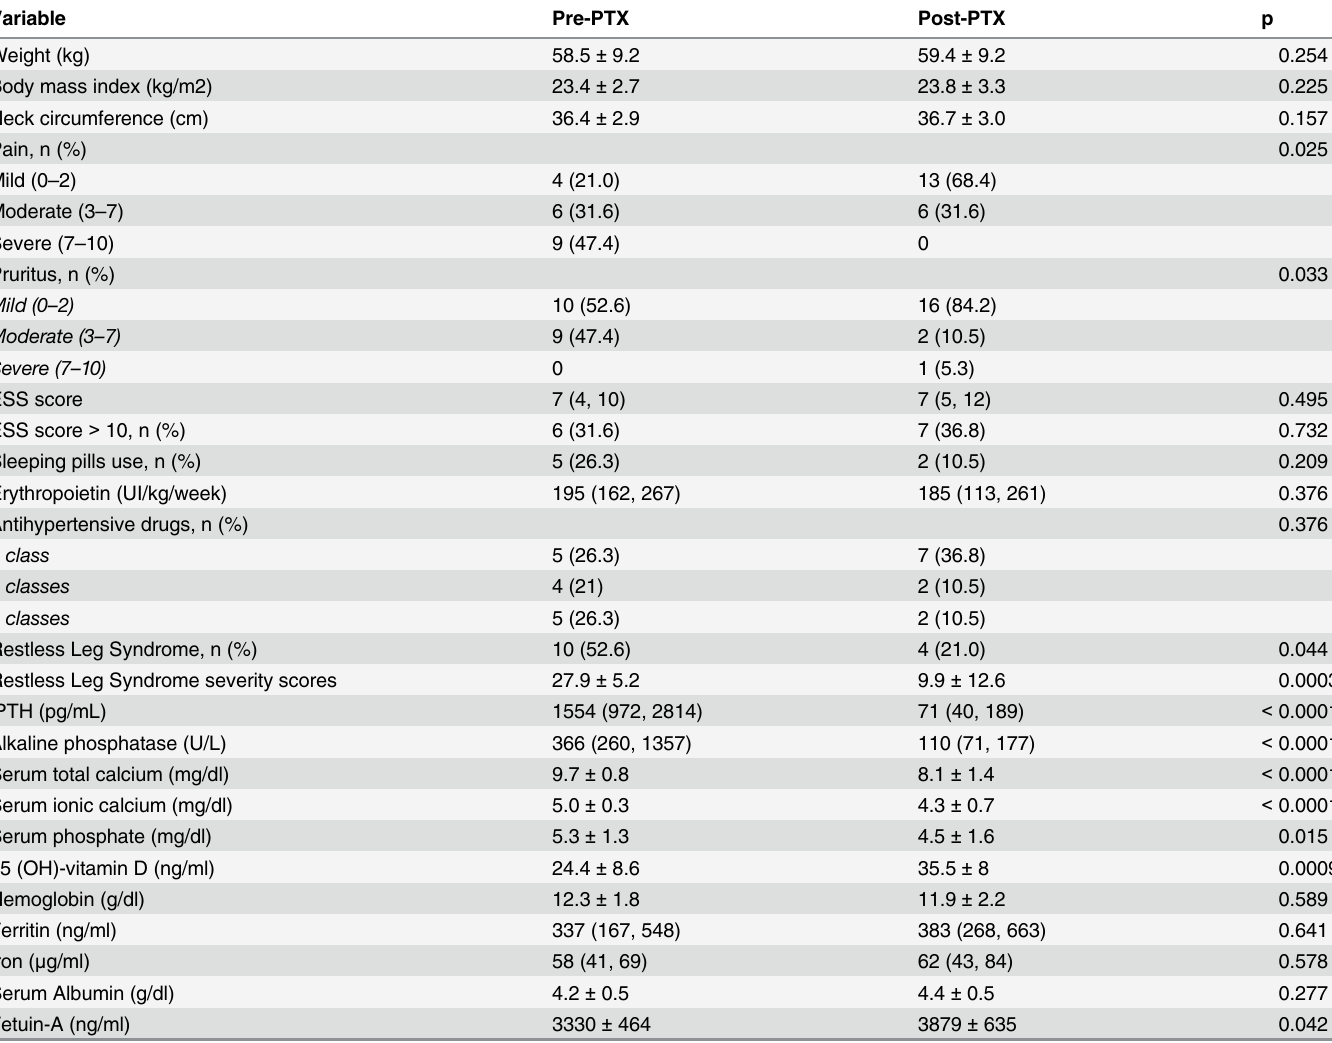
Table 2. Demographic, clinical and biochemical characteristics pre- and post-parathyroidectomy (PTX).